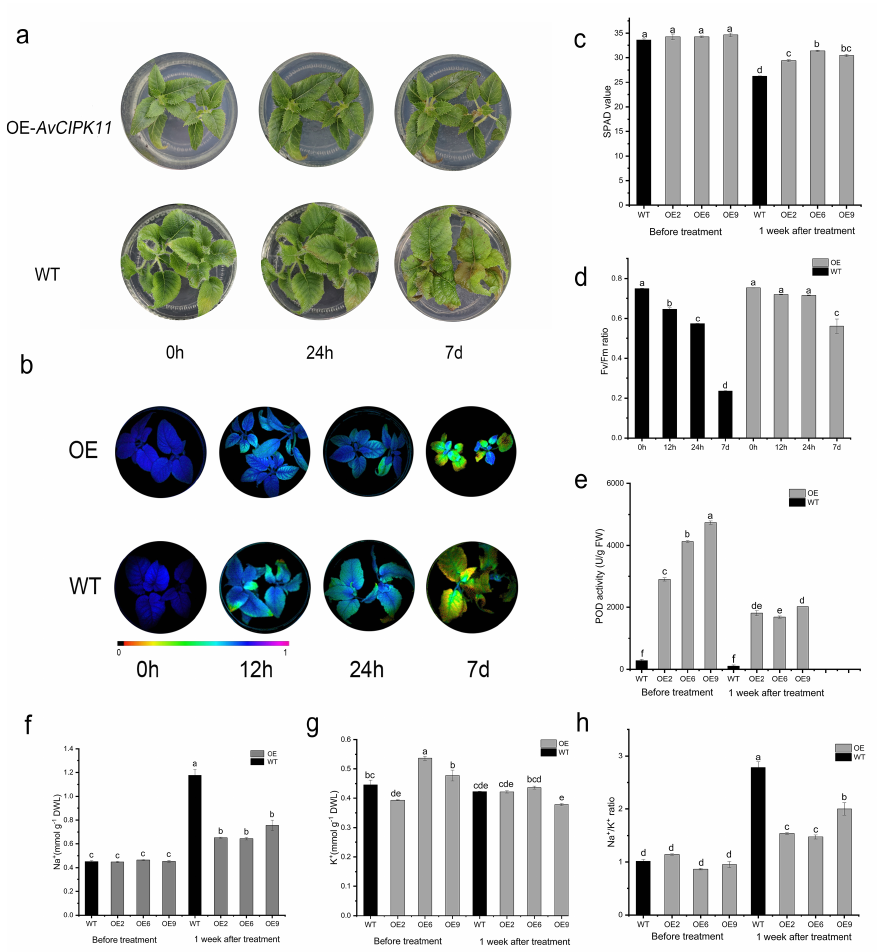
Figure 7. Functional validation of AvCIPK11 in kiwifruit under salt stress. ( a ) Phenotypes of WT ( A. chinensis cv. ‘Hongyang’) and OE kiwifruit plants under normal and salt stress conditions. ( b ) De- tection of chlorophyll fluorescence in WT and OE plants under different time points of salt stress. The images were take using an IMAGING-PAM chlorophyll fluorometer. ( c ) The SPAD value in WT and OE plants before and after salt stress treatment. ( d ) The Fv/Fm ratio in WT and OE plants before and after salt stress treatment. ( e ) The POD activity in WT and OE plants before and after salt stress treatment. ( f–h ) The content of leaf Na + , K + , and the ratio of Na + /K + in WT and OE plants before and after salt stress treatment. Different letters ( a – f ) represent significant mean differences at p <